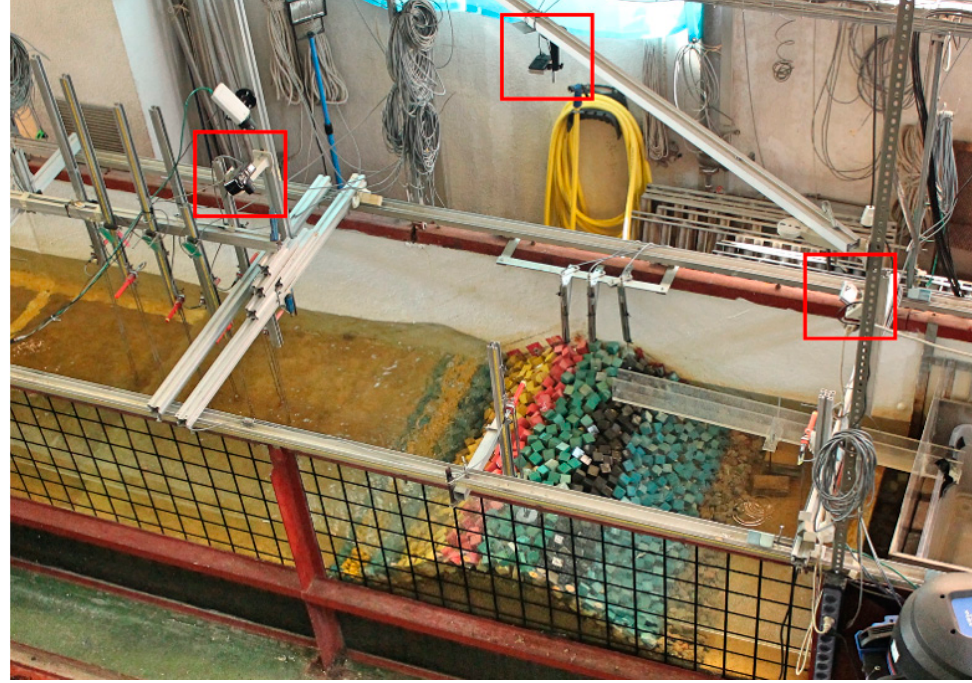
Figure 3. Location of the cameras and experimental set up for cube-armored